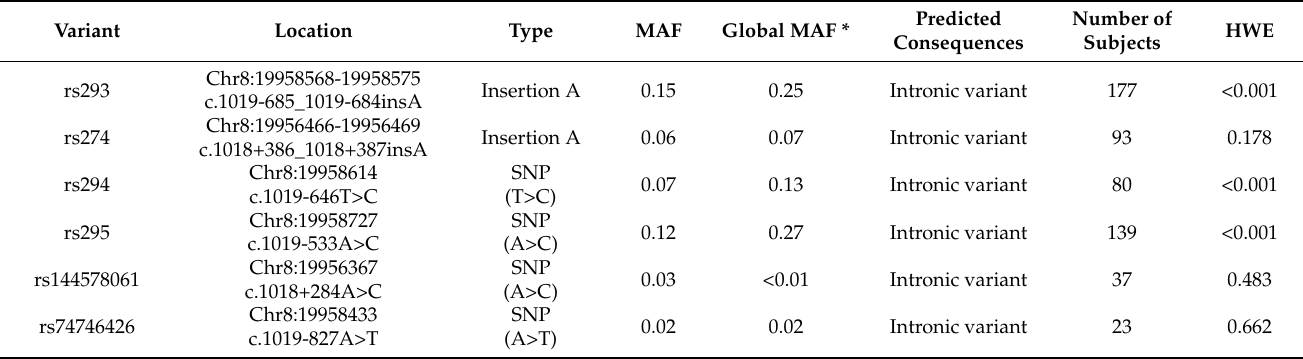
Table 2. The sixteen identified variants in intron 6 (Chr8:19956194-19956691) of the LPL gene (NM_000237.3) with their location, type, predicted consequence, minor allele frequency (MAF) and global MAF, number of subjects with the mutated alleles among the study population ( n = 729) and the calculated Hardy–Weinberg equilibrium (HWE). All genomic positions are derived from Ensembl